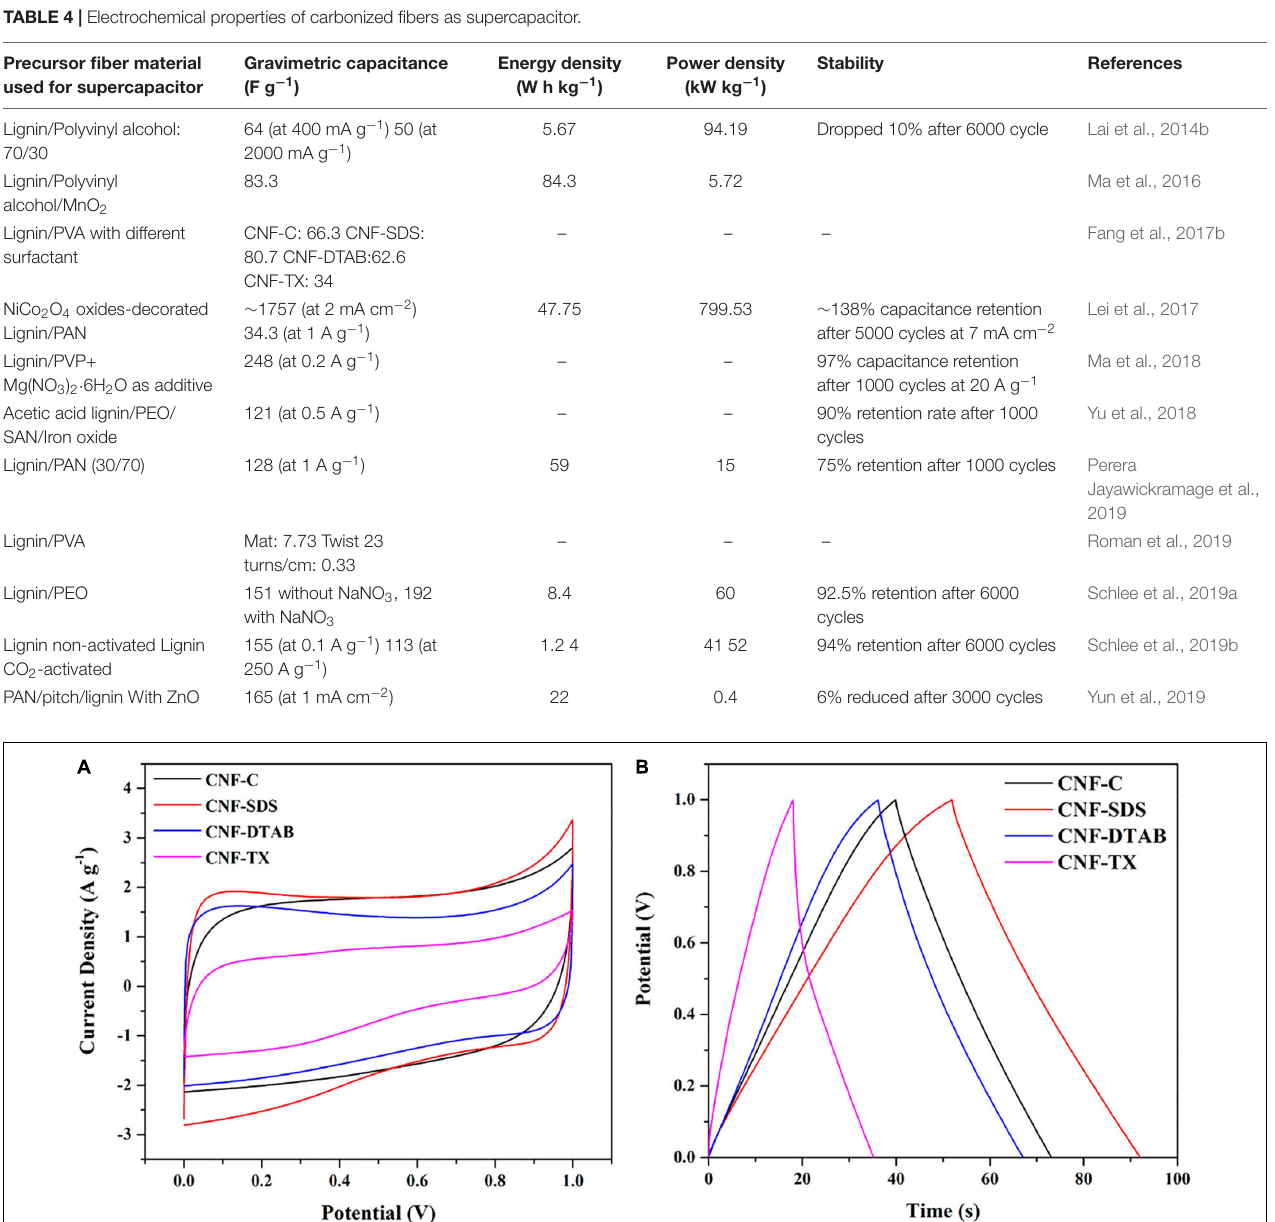
FIGURE 6 | Electrochemical characterizations of carbon fiber membranes from solutions with varying surfactants. (A) Cyclic voltammograms curves at 50 mv s − 1 ; (B) galvanostatic charge-discharge curves at 1 A g − 1 . The carbonized mats were labeled as CNF-C, CNF-SDS, CNF-DTAB, and CNF-TX for fibers spun from solutions without surfactant, 1.0% SDS (Anionic surfactant sodium dodecyl sulfate), 1.0% DTAB (Cationic surfactant N,N,N -trimethyl-1-dodecanaminium bromide), and 1.0% TX-100 (Nonionic surfactant Triton X-100), respectively. Fang et al. (2017b) with permission from the American Chemical